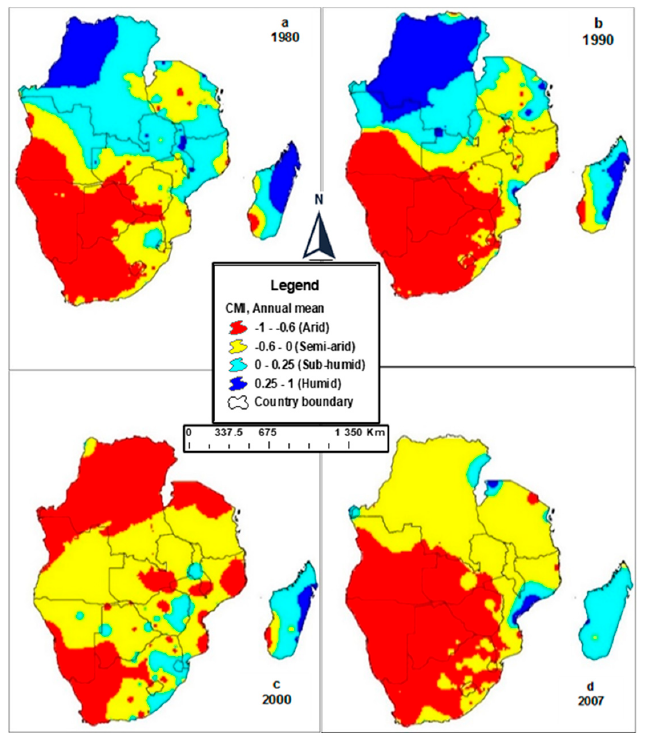
Figure 4. Spatial − temporal changes in water scarcity and level of aridity in the Southern Africa. The degree of aridity is has worsened with time as depicted by the difference in the arid area ( − 1 − 0.5) between 1960 and 2007 ( a – d ).